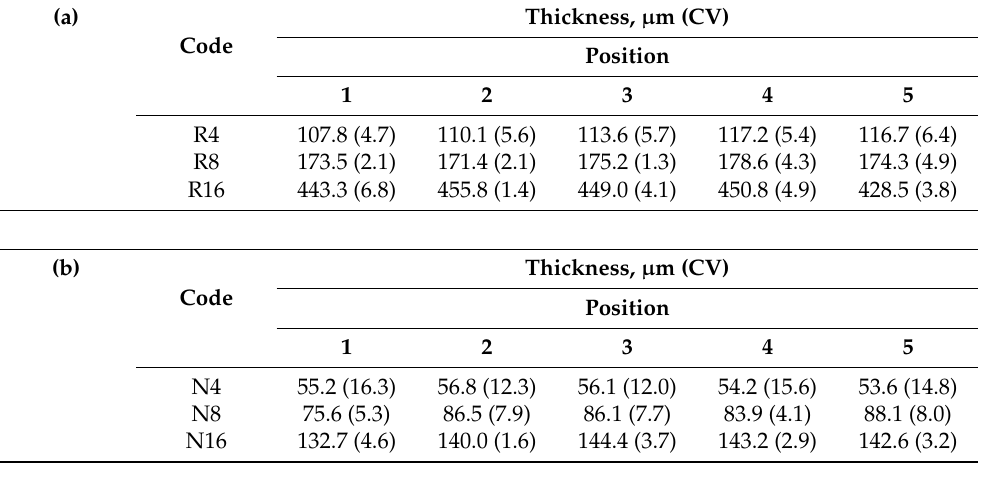
Table 3. Thickness of (a) Eudragit ® RS/RL and (b) Eudragit ® NE-based coatings applied to I-shaped samples. The coefficient of variation (CV) is reported in brackets.